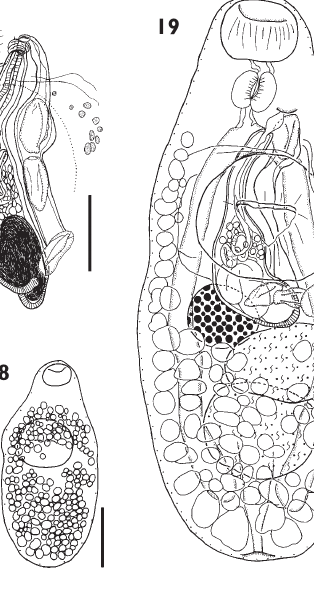
Figs 19-20. Macvicaria fl exuomeatus n. sp. ex Cheilodactylus rubrolabiatus . 19. Whole-mount ventral view. 20. Dorsal distribution of vitelline follicles. Scale bars : 19, 20, 250 μm.